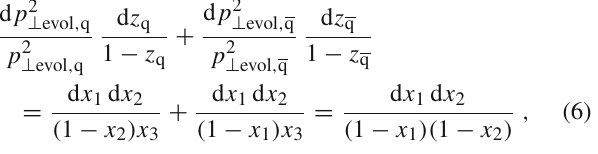
some p ⊥ scale is resolved, how might that picture change d p ⊥